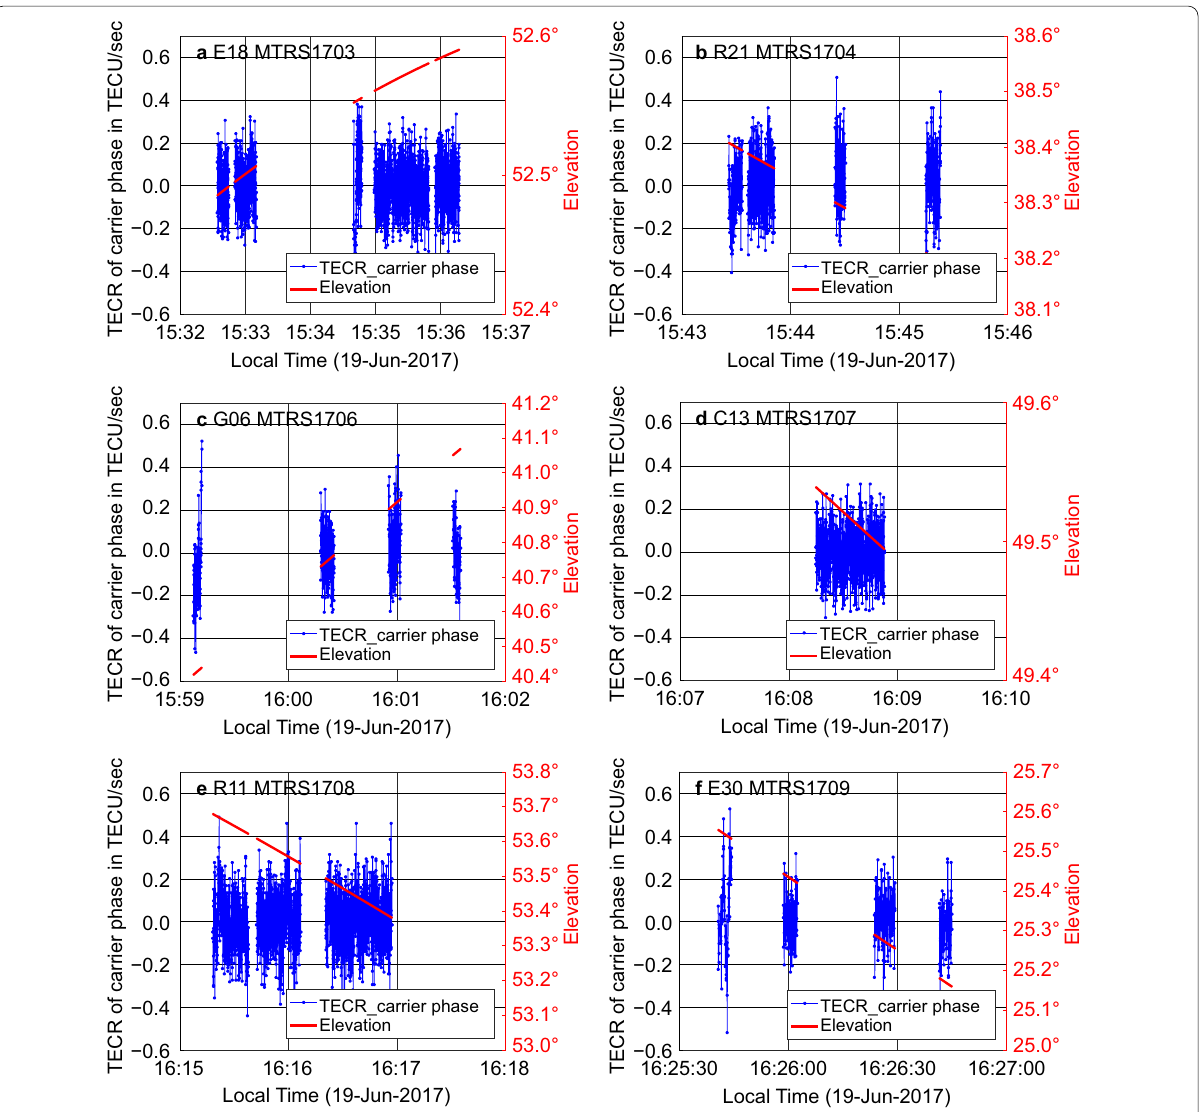
Fig. 11 TECR derived from six randomly selected satellites after applying the generalized ESD test with α = 0.05, r = 40 . The results are presented in ( a - f